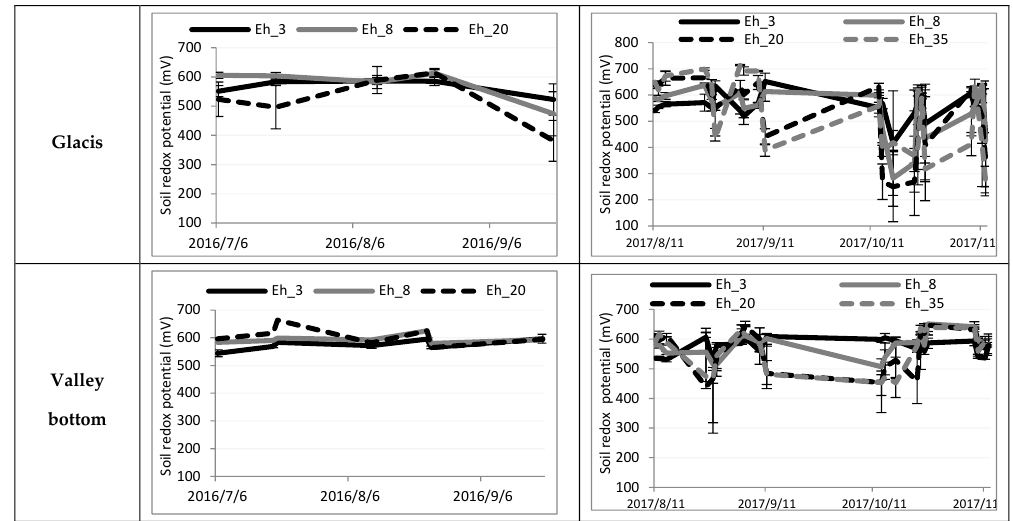
Figure 8. Soil redox potential at different soil depths during the 2016 and 2017 growing seasons. Error bars indicate the standard errors of the mean.